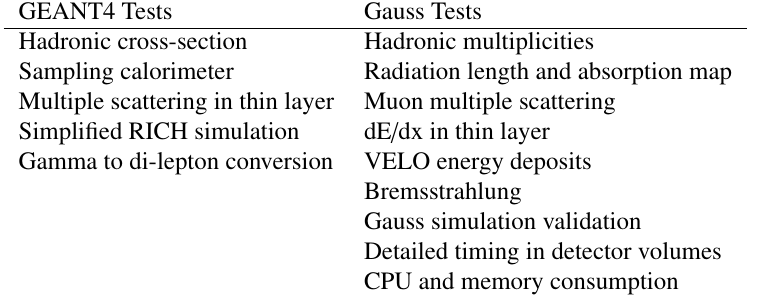
Table 1. The list of deployed LHCb performance and regression tests. The left column corresponds to the GEANT4 based tests. The right column lists the Gauss based